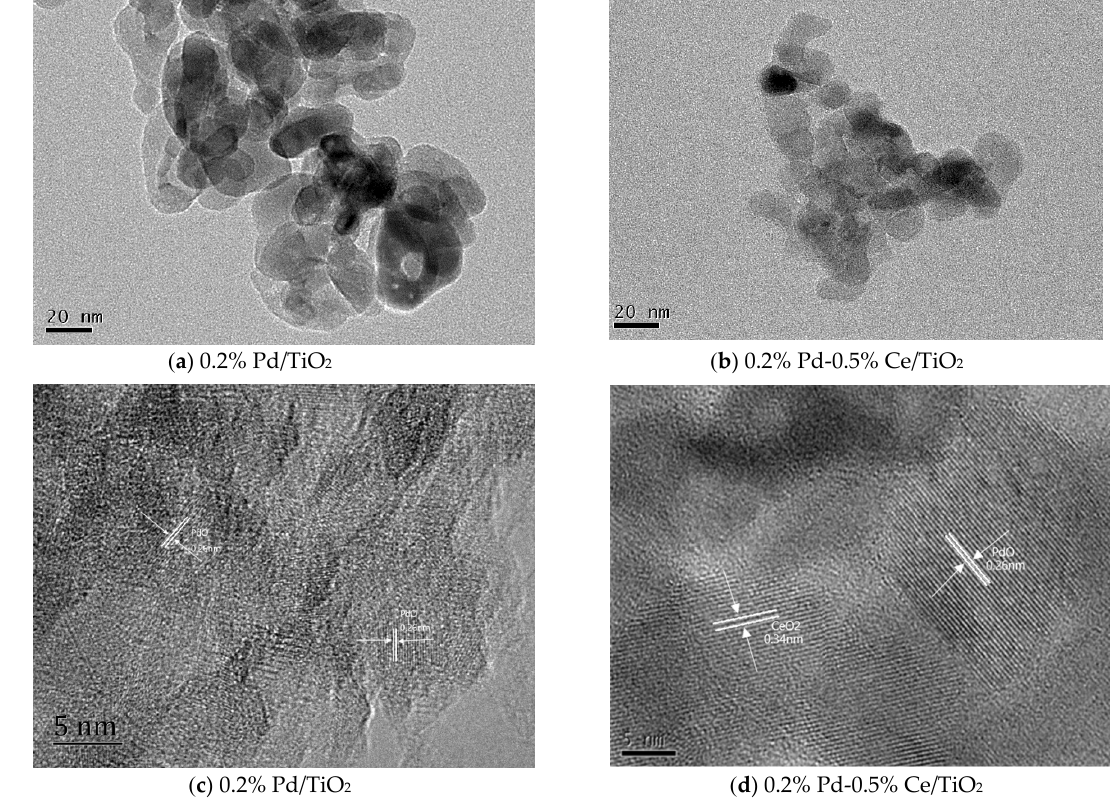
Figure 2. TEM images of 0.2% Pd / TiO 2 ( a ) and 0.2% Pd-0.5% Ce / TiO 2 ( b ); HRTEM images of 0.2% Pd / TiO 2 ( c ) and 0.2% Pd-0.5% Ce / TiO 2 ( d ).